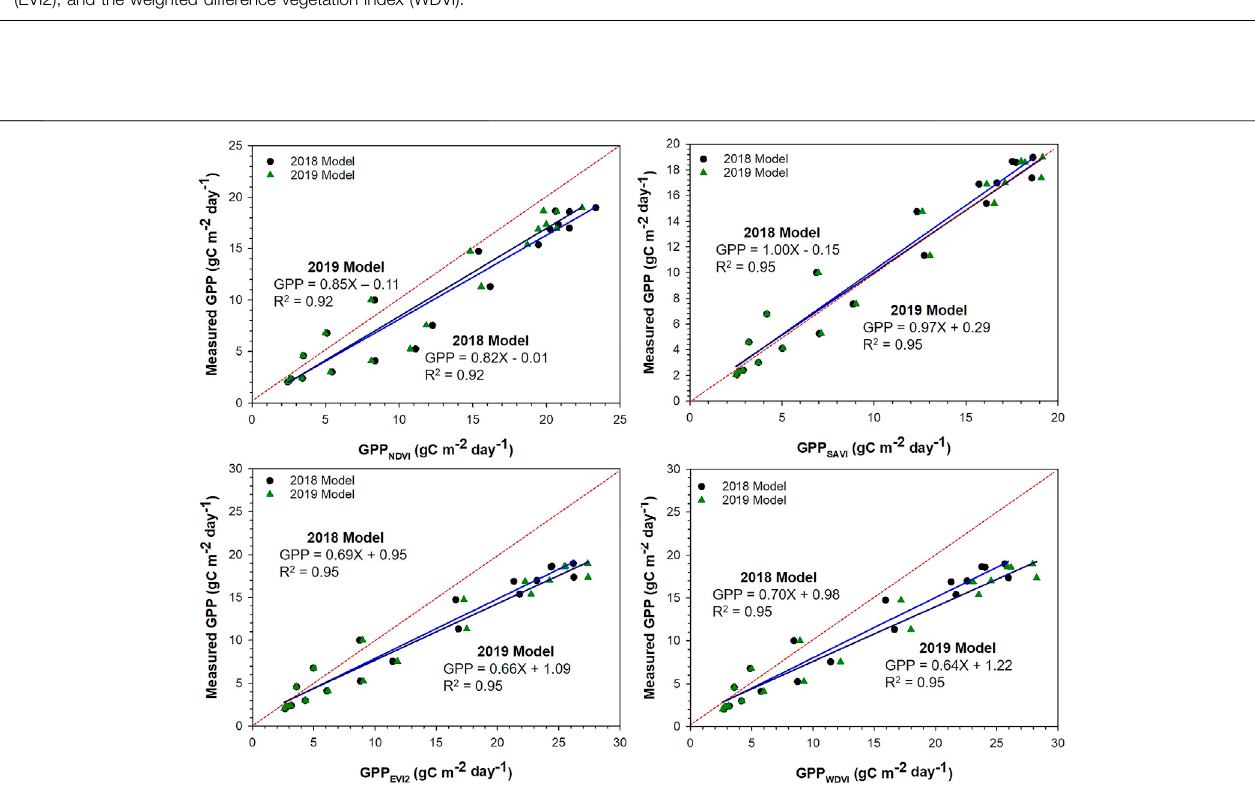
FIGURE 6 | Measured 2017 gross primary production (GPP) against predicted GPP using the 2018 and 2019 GPP models. Straight lines are regression lines and the dotted red line is the 1:1 line.